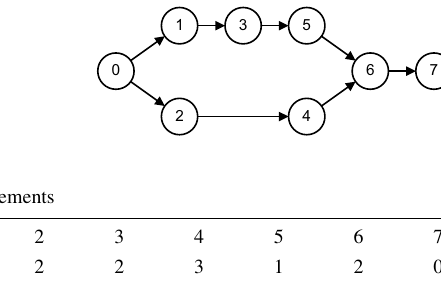
Fig. 1 Activity on node graph